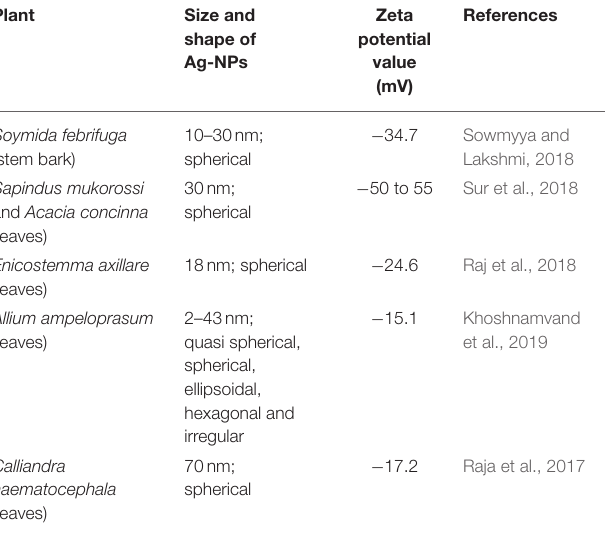
TABLE 1 | Summary of the synthesis of Ag-NPs using other plant extracts. Plant